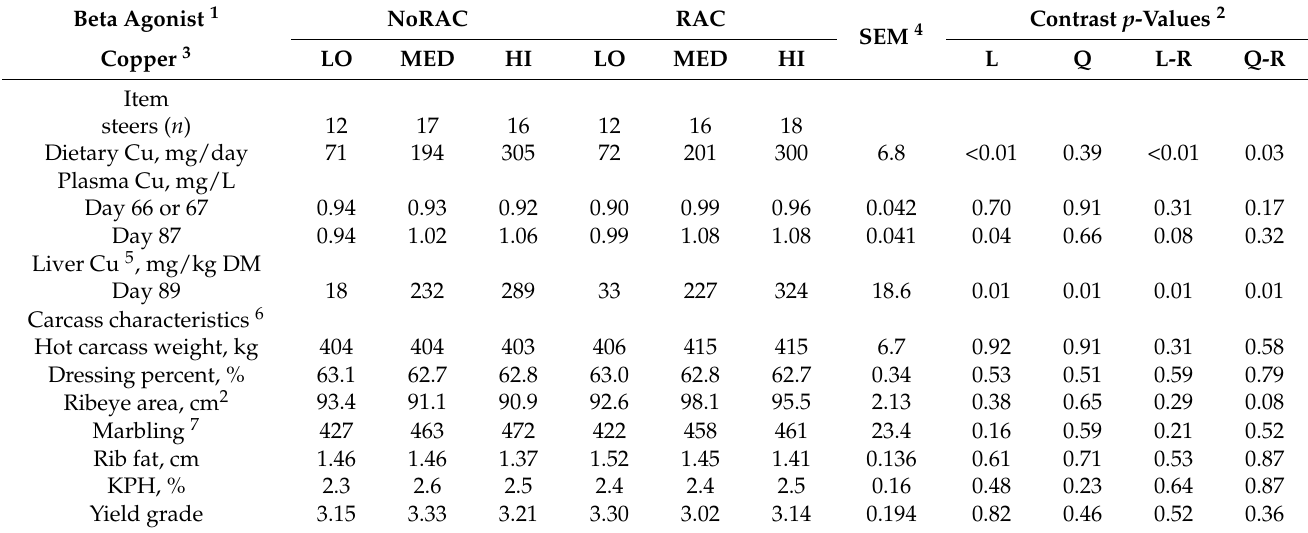
Table 5. The effect of copper supplementation and ractopamine hydrochloride treatment on indicators of copper status and carcass characteristics of beef finishing